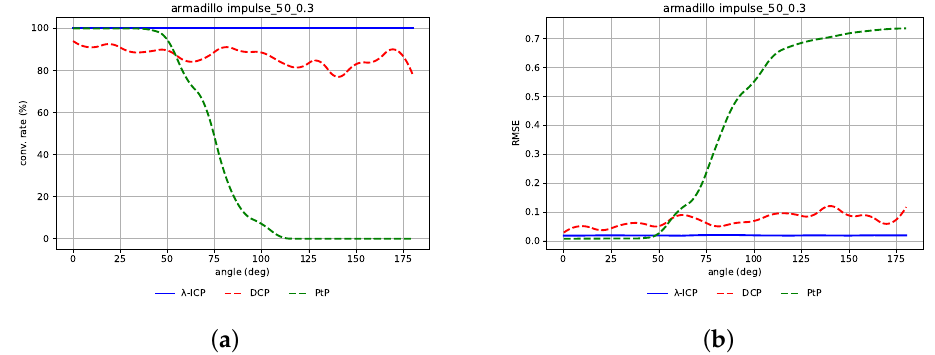
Figure 19. ( a ) Convergence rate of λ -ICP (blue), DCP (red), PtP (green) algorithms for Armadillo with impulse noise; ( b ) mean RMSE (for transformation matrices) of λ -ICP (blue), DCP (red), PtP (green) algorithms for Armadillo with impulse